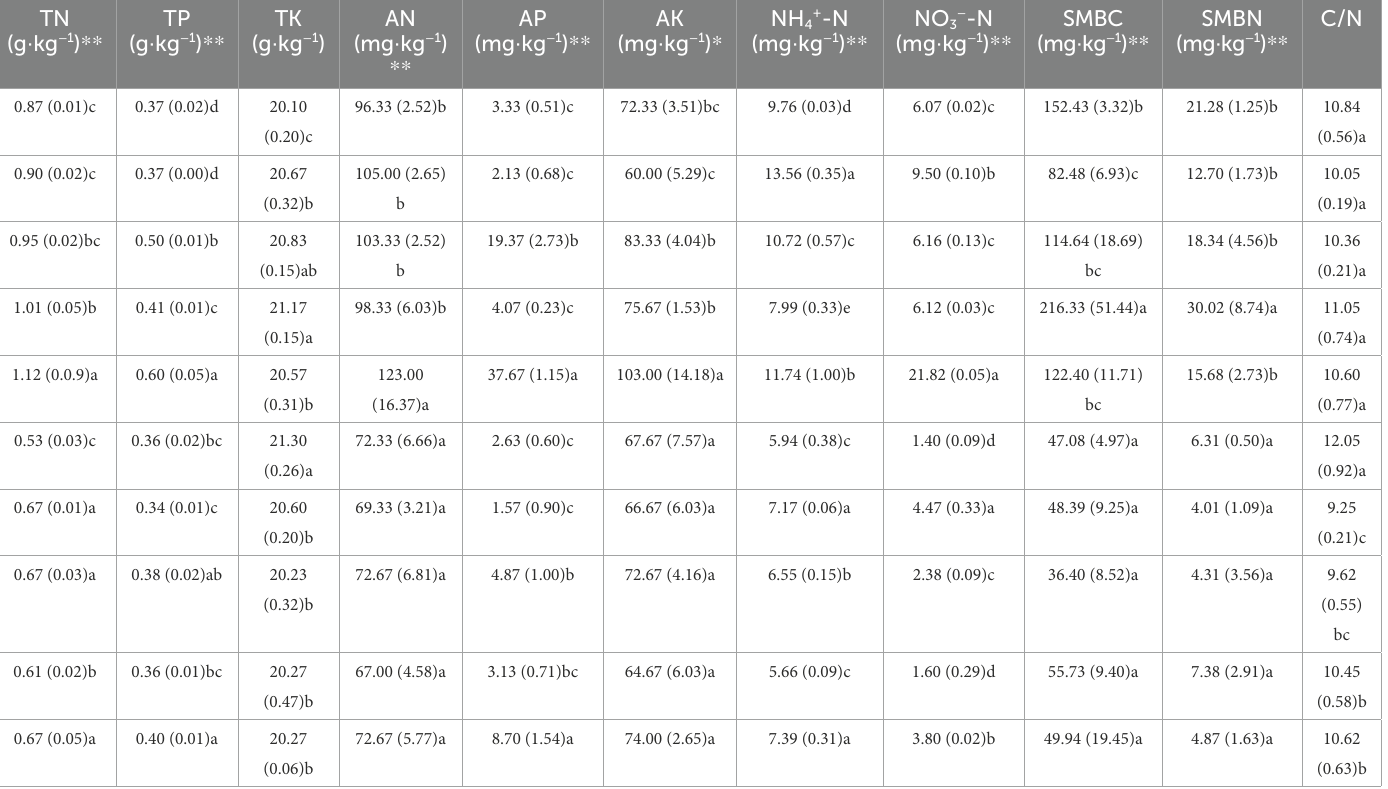
TABLE 2 Basic characteristics of soil properties under different fertilization regimes and soil layers. Soil